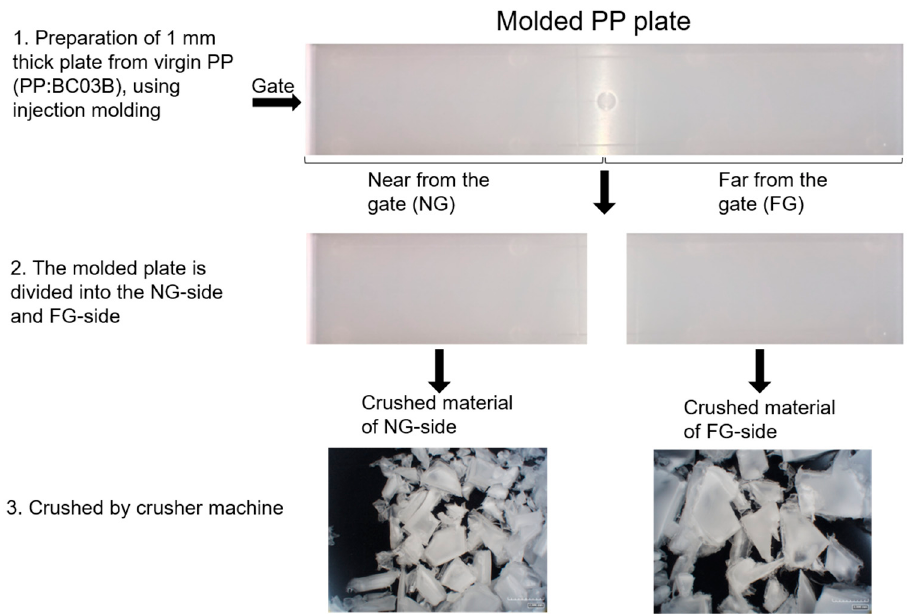
Figure 1. Preparation of recycled PP copolymer for melt spinning.